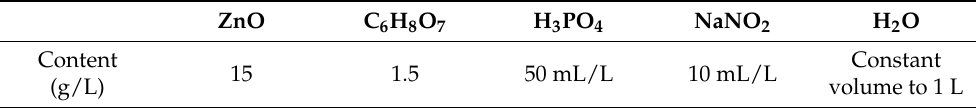
Table 3. Conventional phosphated sample solution